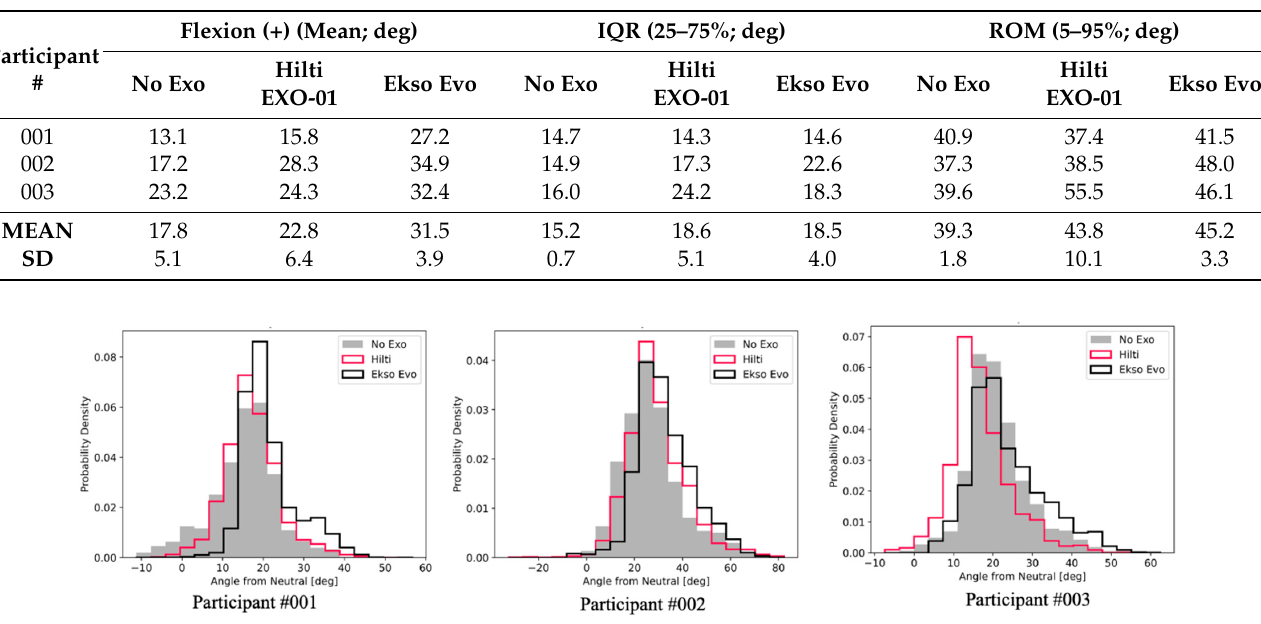
Figure 11. Histograms of abduction/adduction of the right shoulder for block installation.